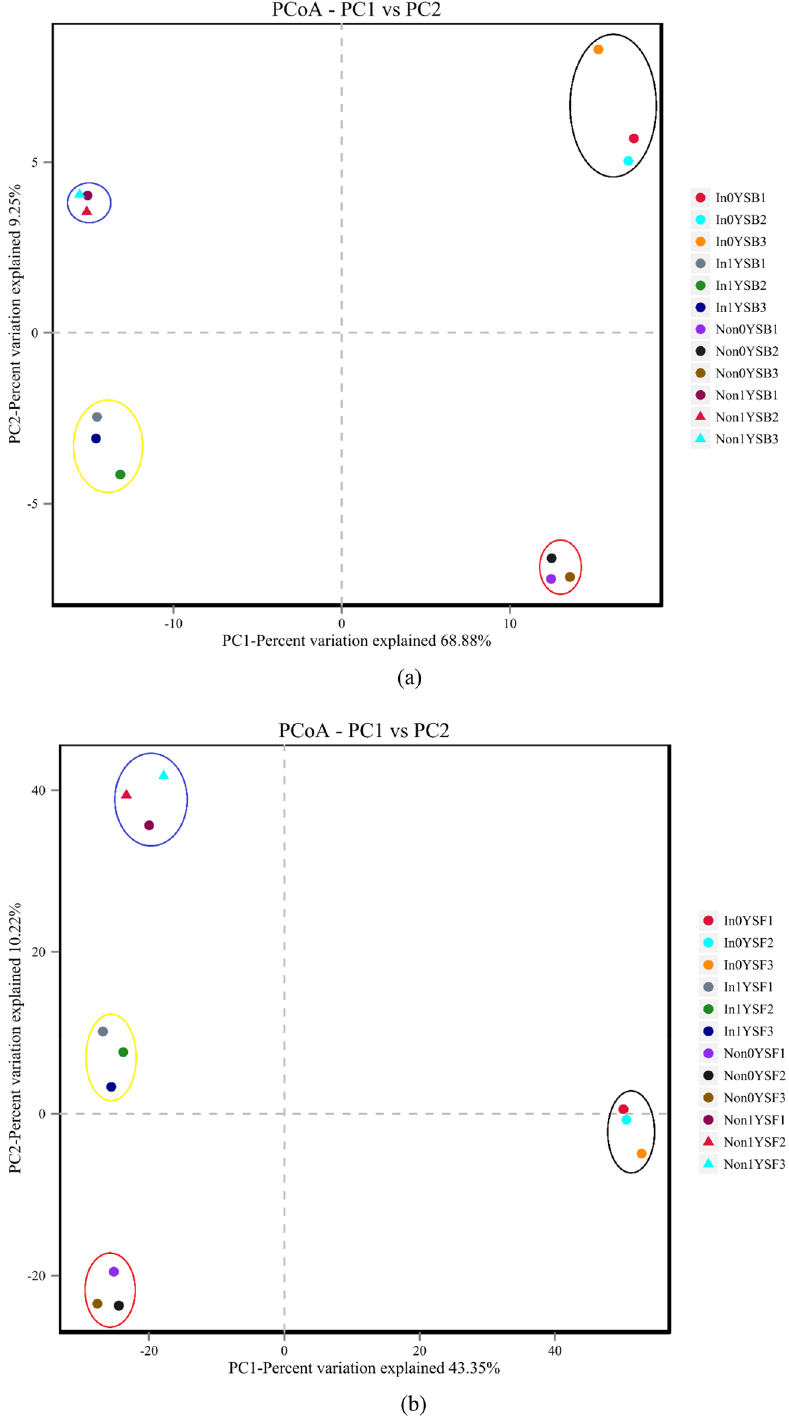
Figure 2. Principal coordinates analysis (PCoA) of the composition of bacterial ( a ) and fungal ( b ) communities. Non represents non-inoculated with R. intraradices . In represents inoculated with R. intraradices . 0Y and 1Y represent 0 year and 1 year of continuous cropping, respectively. SB represents bacteria in rhizosphere soil. SF represents fungi in rhizosphere soil. The numbers 1, 2 and 3 represent three